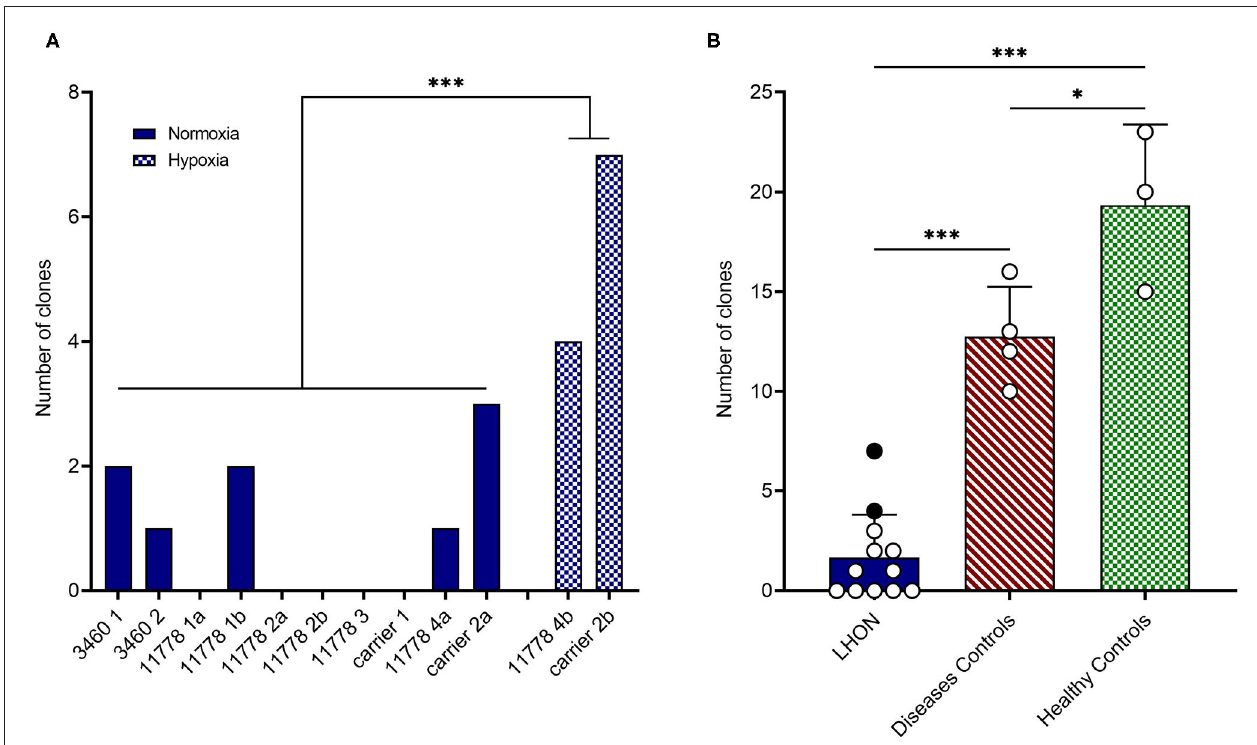
FIGURE 1 | LHON cell lines reprogramming efficiency. (A) Number of hiPSC clones obtained by reprogramming affected or non-affected (carrier) LHON-derived fibroblasts or PBMC under normoxia (solid blue bars) or hypoxia (cross-hatched blue bars) conditions. (B) Comparison between grouped numbers of hiPSC clones obtained from LHON (solid blue bar), disease controls including non-LHON mitochondrial diseases (hatched red bar), and healthy controls (cross-hatched green bars) cell lines. The dots represent the number of clones obtained under normoxia (white dots) or hypoxia (black dots) conditions. *** p < 0.001, * p <